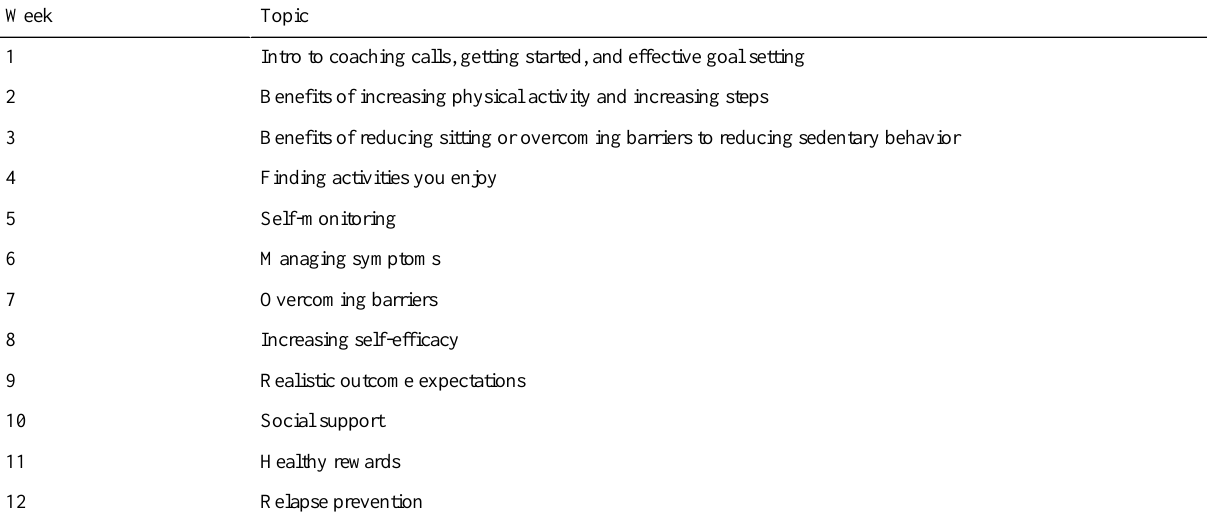
Table 5. Weekly coaching call topics for Fit2ThriveMB intervention group.